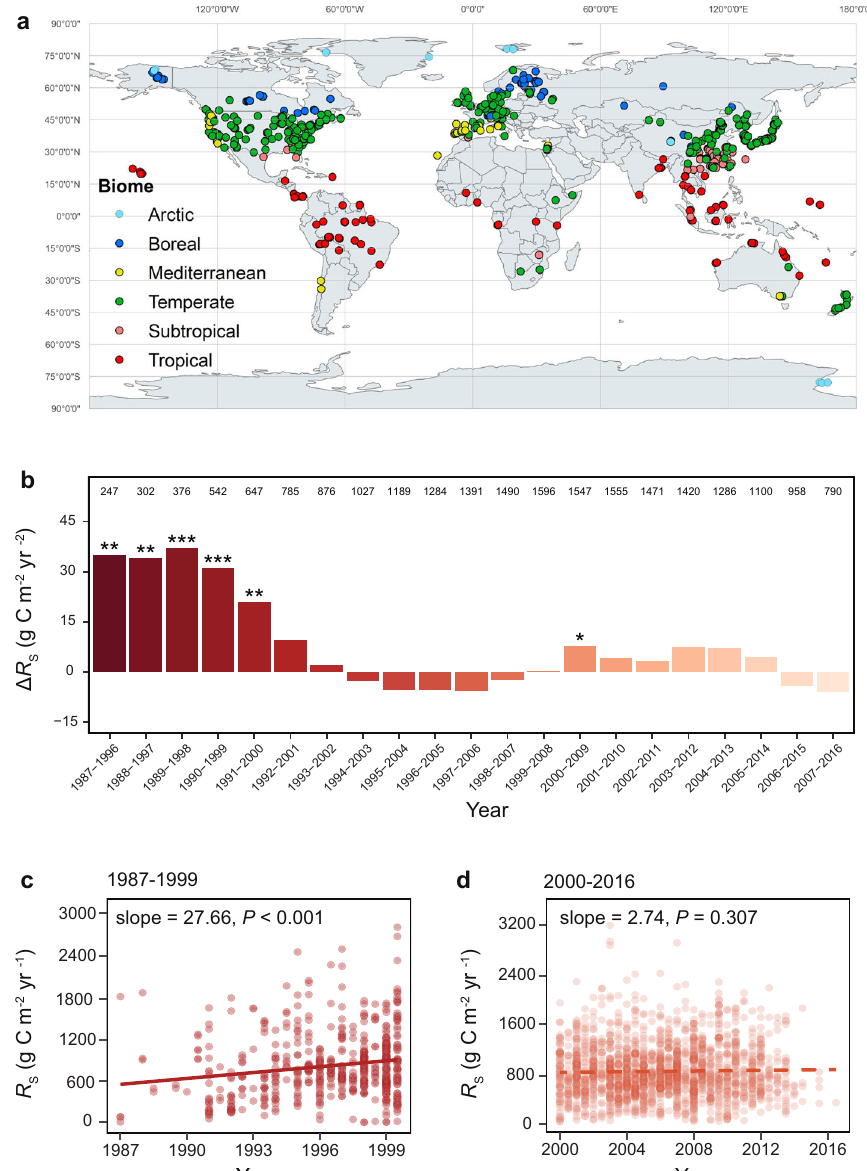
Fig. 1 Geographical distribution of R S data and temporal changes of R S in different time periods. a A total of 2,428 observations in 693 published studies were retrieved from the SRDB, covering six types of biomes as denoted by different colors. The distribution of biomes displays clear latitude-dependent features. b The temporal trend of R S changes in each decade based on the moving subset window analysis. The bars indicate the rates of R S changes per decade, calculated as average annual R S change ( Δ R S ). The number above each bar refers to the number of R S records belonging to the subset window. The color scale of the bars corresponds to the colors representing different periods in ( c , d ).*** P < 0.001, ** P < 0.010, * P < 0.050. c The relationship between R S and year in 1987 – 1999. d The relationship between R S and year in 2000 – 2016. The slope of linear regression indicates the rate of R S changes in different time periods. The dot density represents data density at each point. Solid lines indicate signi fi cant trends ( P < 0.050), while dashed lines indicate insigni fi cant trends ( P ≥